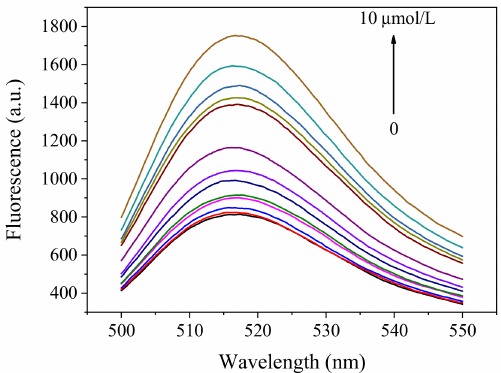
Figure 10. Fluorescence spectra of Fe 3 O 4 @Au–FITC in the presence of various concentrations of Pb 2+ .